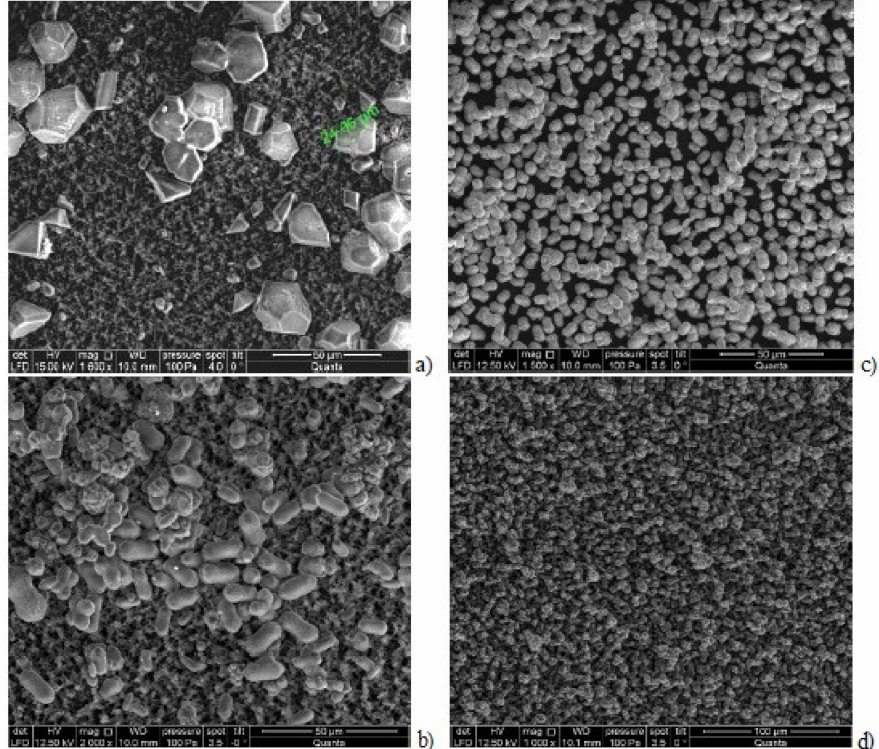
Figure 11. SEM photos of crystals withdrawn from membrane module: ( a ) without antiscalant addition; ( b ) Jurbysoft, 5 ppm; ( c ) Actoscale, 5 ppm; ( d ) Aminat-K, 10